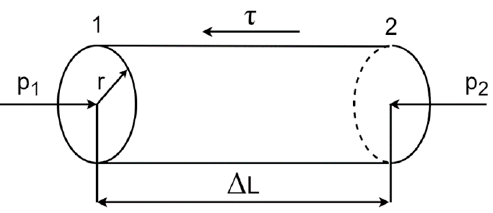
Figure 1. Distribution of stresses during laminar flow of fluid through a pipe. In order to obtain the condition of balance of forces applied at separate mass of fluids, the sum of projections of external forces on the direction of the pipe axis has to equal